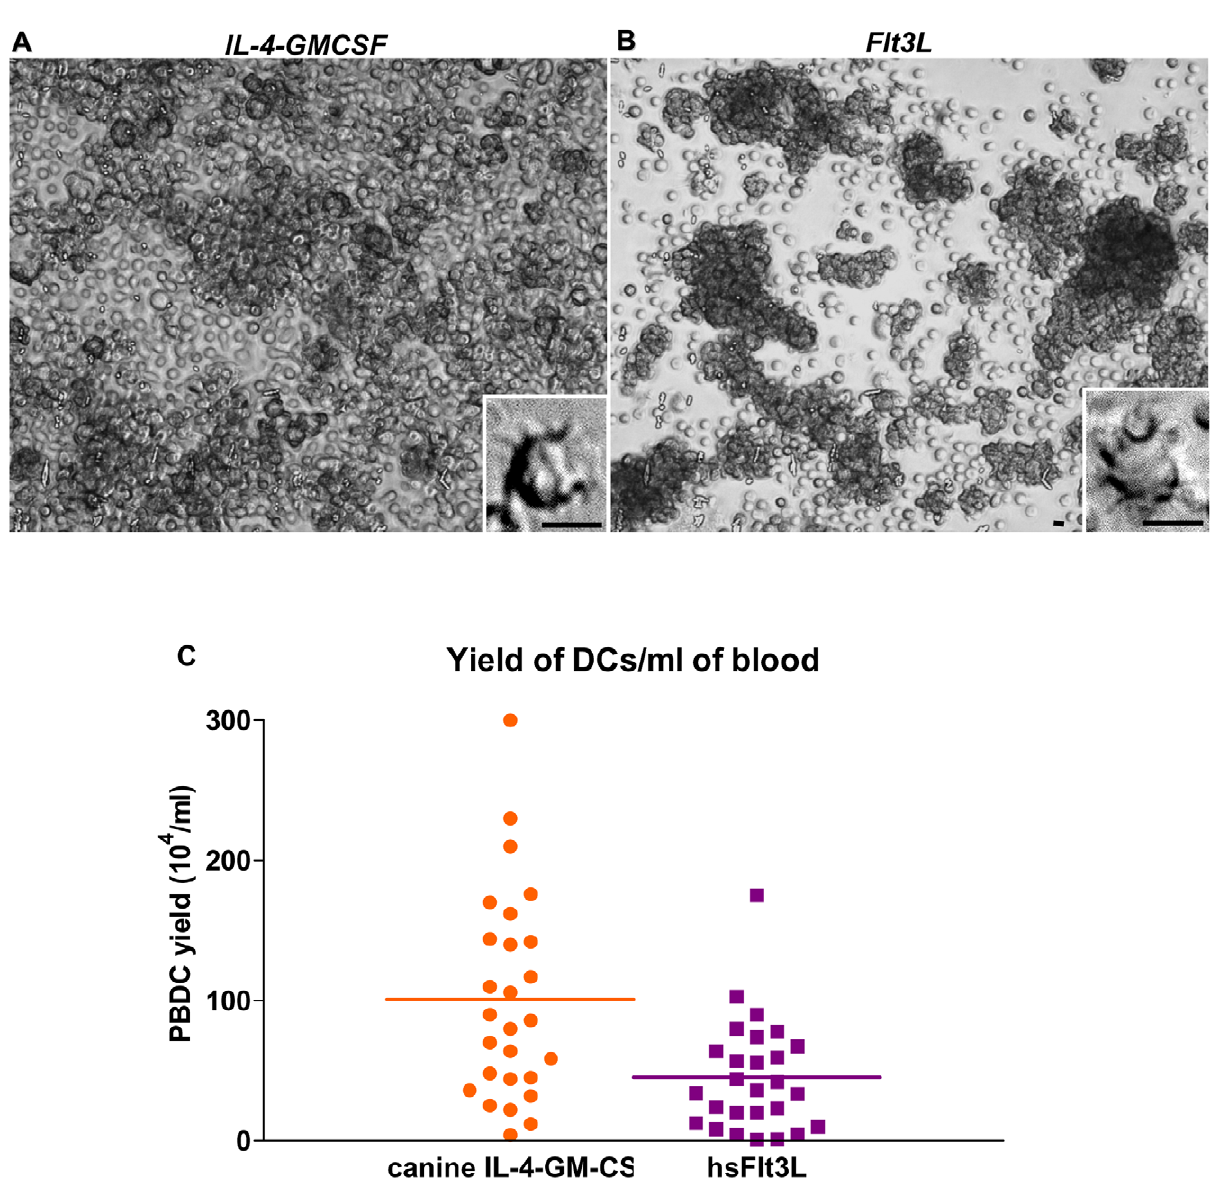
Figure 1. Morphology of peripheral blood-derived dog dendritic cells cultured with canine IL-4 + GM-CSF or Ad.hFlt3L conditioned medium. White cells from dog peripheral blood were purified using Lymphocyte Separation Media and cultured in the presence of recombinant canine IL-4 (50 ng/ml) and GM-CSF (33 ng/ml) or Ad.hsFlt3L conditioned medium (10 ng/ml). The images show the appearance of the culture after 7 days in culture. Low magnification images (20 6 ) show typical spheres formed in culture supplemented with canine IL-4 + GM-CSF ( A ) or hsFlt3L ( B ). Insets show higher magnification images of cells that exhibit typical long cytoplasmic processes characteristic of dendritic cell morphology. Scale bars: 10 m m. C , After 7–9 days in culture non-adherent cells were collected and counted. The graph shows the yield of cells per ml of blood obtained from 27 dogs after culture with hsFlt3L or canine-IL-4/GM-CSF.